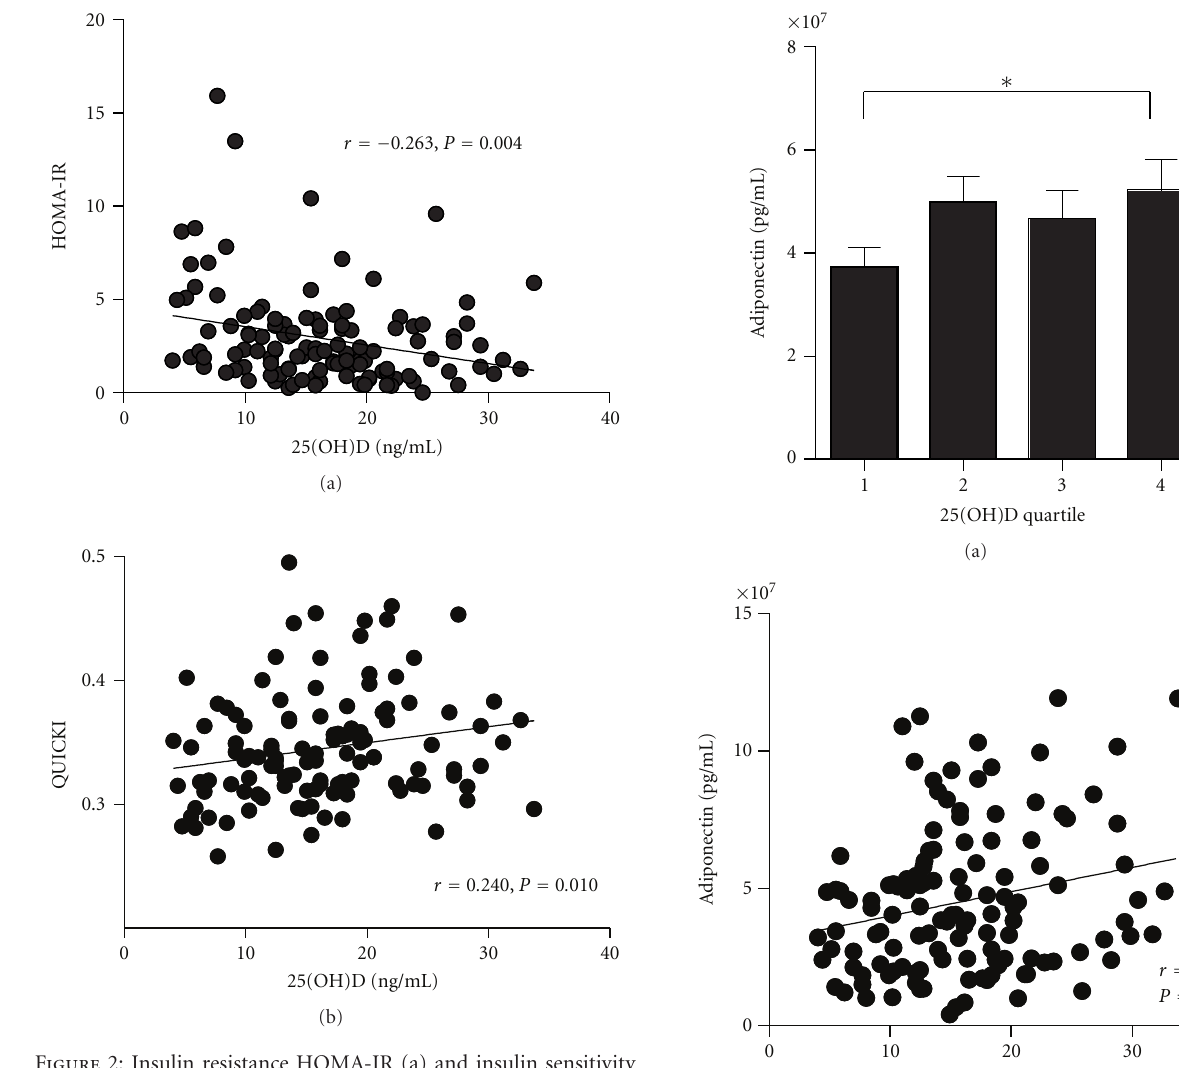
Figure 2: Insulin resistance HOMA-IR (a) and insulin sensitivity QUICKI (b) concentration in relation to 25(OH)D serum levels in obese children.